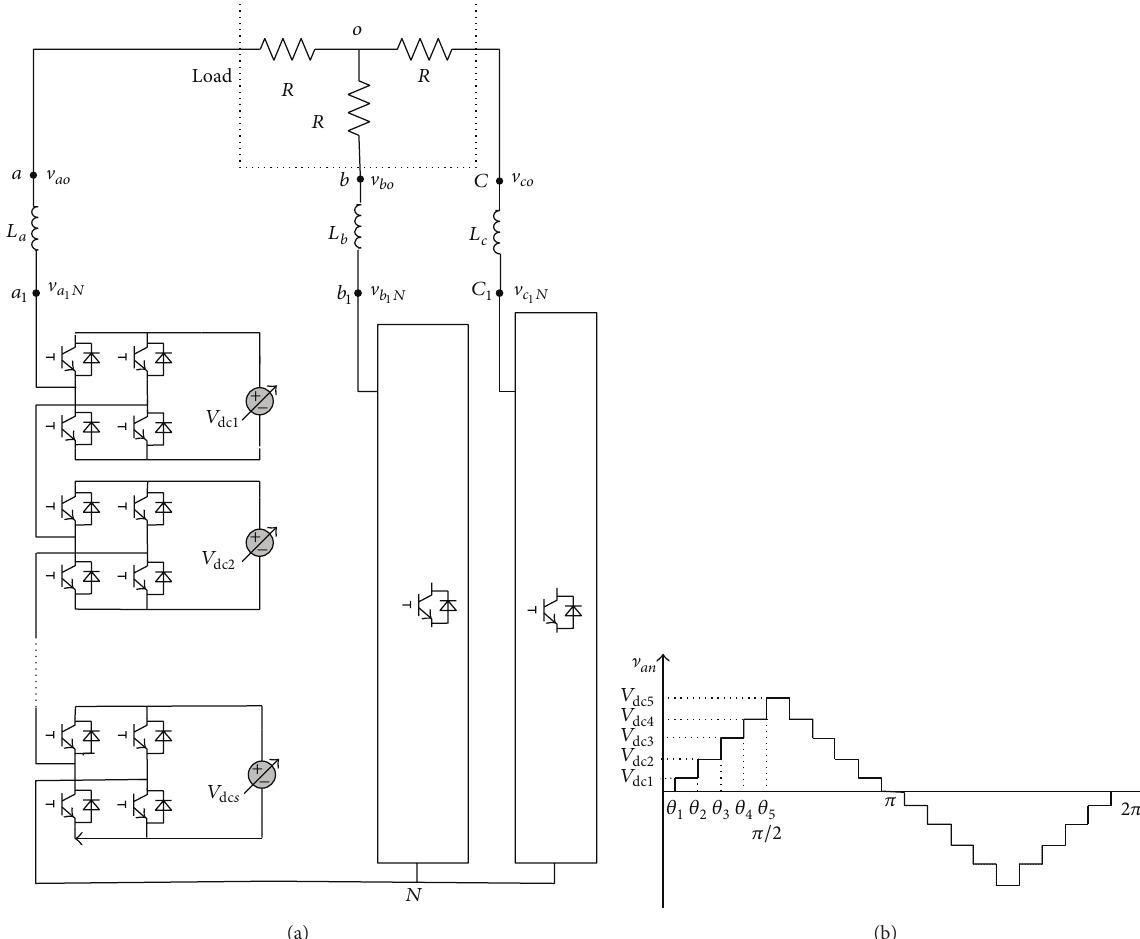
Figure 1: (a) The structure of a three-phase CHB inverter and (b) output phase voltage V